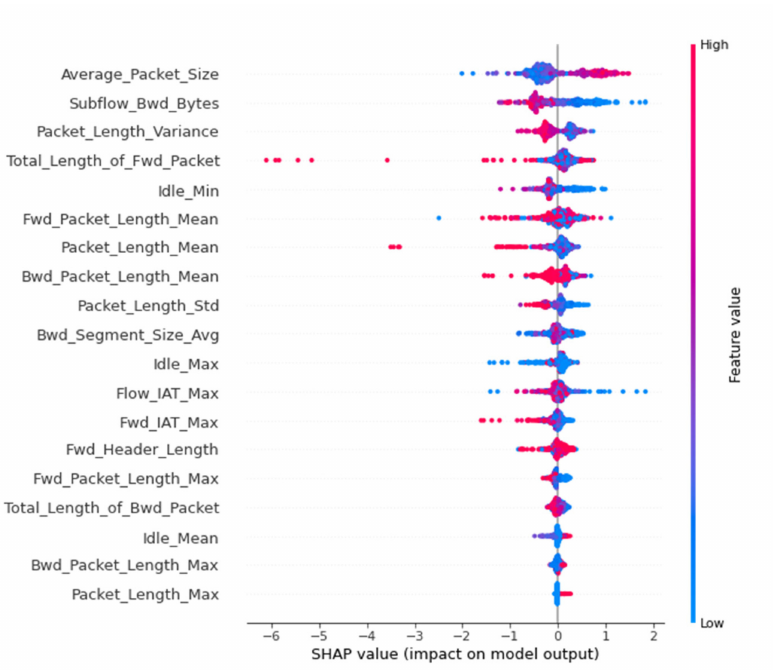
Figure 8. SHAP value impact on model output.